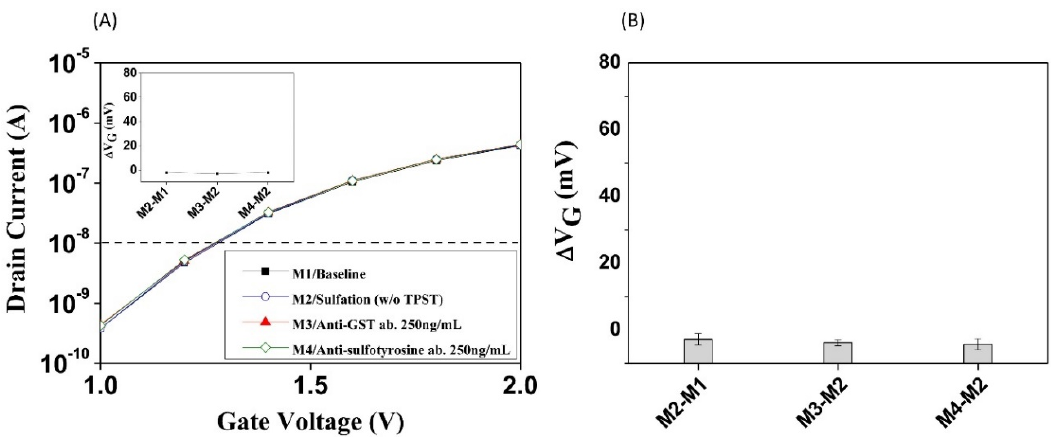
Figure 7. Electrical responses of functionalized pSNWFET to PSGL-1 sulfation without TPST ( A ) I D -V G curve obtained from nonsulfated PSGL-1 following coupled enzyme treatment without the critical enzyme TPST and the interaction with anti-sulfotyrosine, and anti-GST antibodies as the controls. ( B ) Average Δ V G value of Figure 7A.